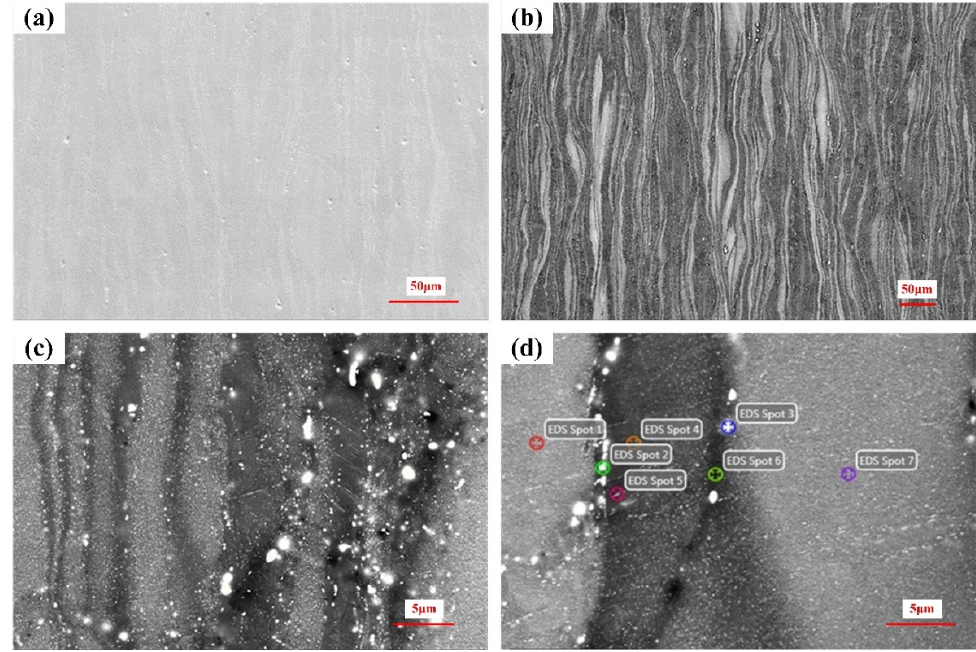
Figure 4. ( a ) low-multiple, ( b ) medium-multiple, ( c ) high-multiple SEM morphology and ( d ) EDS of original ZK61M alloy. Table 2. Chemical element content at each representative point (wt. %). Number